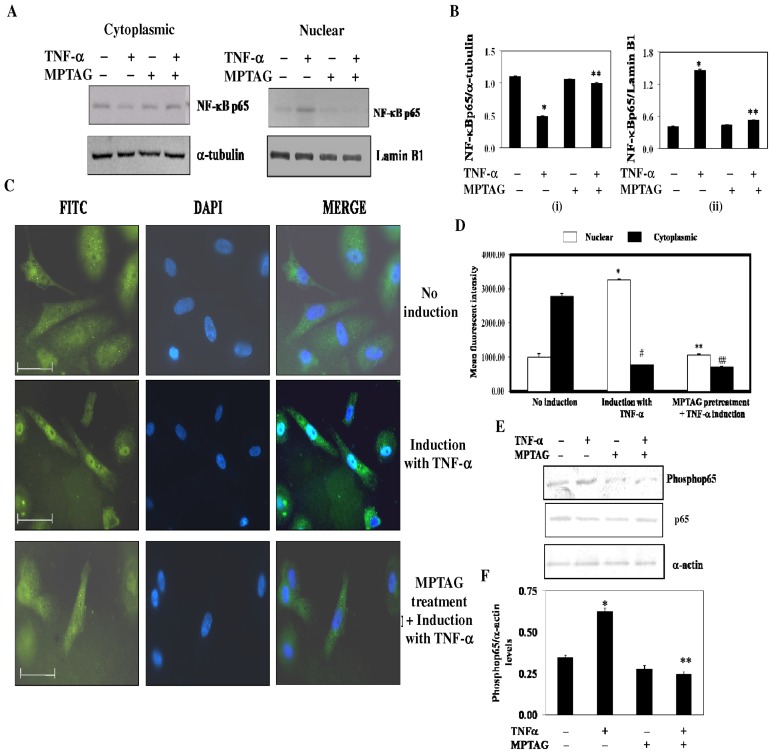
MPTAG prevents the TNF-α-induced NF-κB translocation in human endothelial cells.(A) The cells were pretreated with MPTAG (400 µM) and induced with TNF-α. The cytoplasmic (CE) and nuclear (NE) extracts were prepared and processed for western blot analysis. (B) The intensity of bands were densitometrically scanned and normalized with that of α-tubulin and Lamin B1 in CE and NE extracts, respectively. The values presented are mean ± SEM. *p<0.005 vs. uninduced cells; **p<0.01 vs. TNF-α-induced cells, statistical significance was set at p<0.05. (C–D) The cells were treated and induced as described in ‘A’ and subjected to immunocytochemical analysis using anti-NF-κBp65 and FITC-labeled anti-rabbit antibodies. DAPI was used for staining the nucleus. The mean intensity levels of NF-κB conjugated to FITC, both in the cytoplasm and nucleus, were quantitated and plotted as mean intensity ± SEM. *,#p<0.05 vs. uninduced cells; **,##p<0.05 vs. TNF-α-induced cells, statistical difference was set at p<0.05. The scale bars represent 50 µm (E–F) MPTAG inhibits TNF-α-induced p65 phosphorylation in endothelial cells. The cells were treated and induced followed by western blot analysis as stated in ‘A’. The intensity of bands were densitometrically scanned and normalized with that of α-actin levels. The values presented are mean ± SEM. *p<0.05 vs. uninduced cells; **p<0.02 vs. TNF-α-induced cells, statistical difference was set at p<0.05.